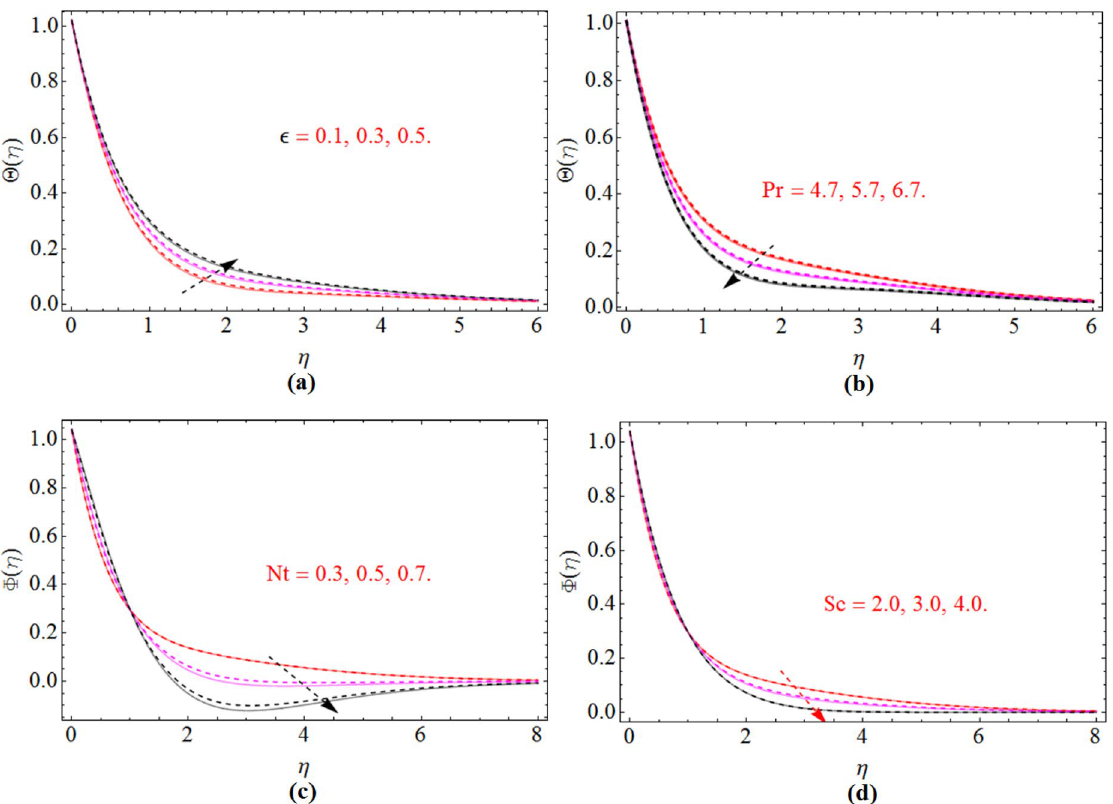
Figure 7. ε and Pr impact on temperature profile �(η) , while Nt and Sc on concentration profile, for S 2 , when S 1 = 0.0. dashed lines for (cid:31) = 0.5 and lines for (cid:31) = − 0.5.